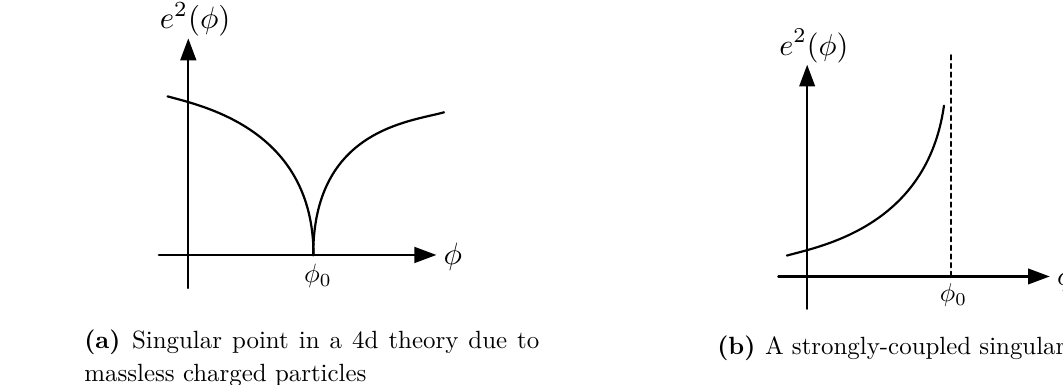
Figure 2. (a) In 4d theories massless charged particles lead to logarithmic infrared divergences, driving the gauge coupling to zero in the deep infrared. (b) A singular point at which perturbation theory breaks down, signaled by diverging or large dimensionless couplings